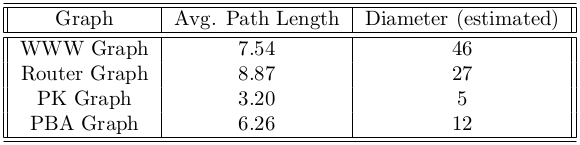
Table from the paper: Parallel Generation of Massive Scale-Free Graphs
Table text:
Graph
Avg.PathLength
Diameter(estimated)
WWWGraph
7.54
46
RouterGraph
8.87
27
PKGraph
3.20
5
PBAGraph
6.26
12